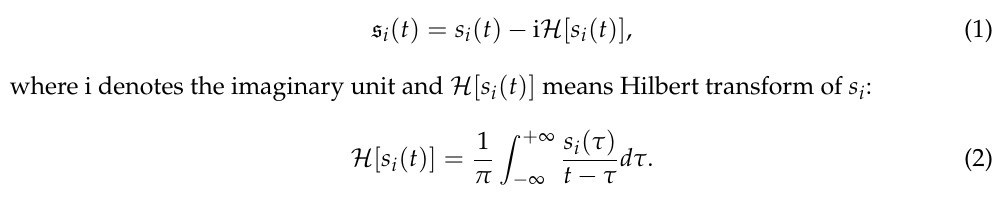
= d ⊗ u w c w is the cross-correlation between the observed trace envelope and the i , env i , env i , env envelopes can produce a more accurate travel-time